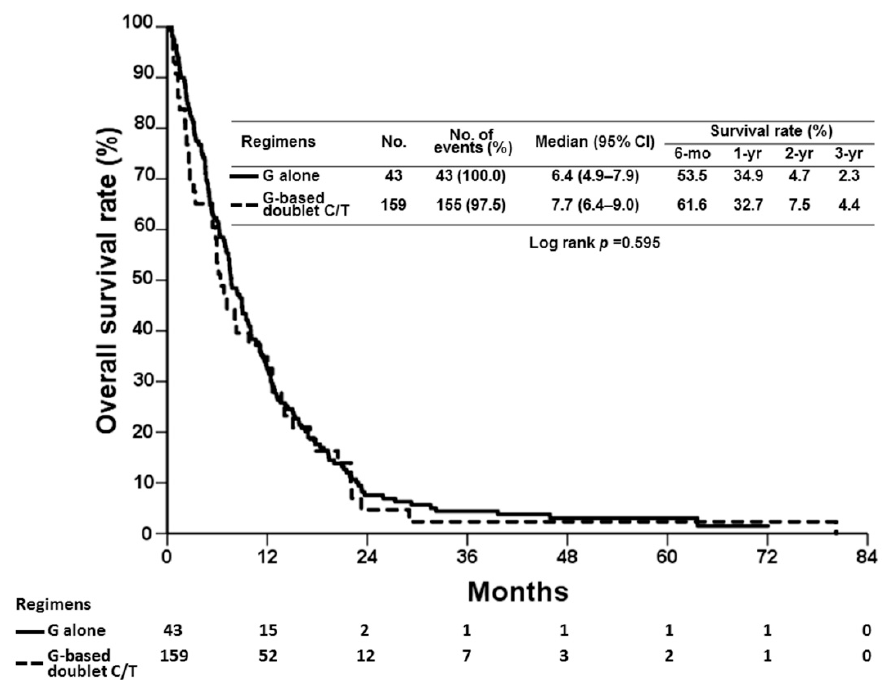
Figure 1. Kaplan–Meier survival curves for overall survival for all patients, stratified according to the chemotherapy (C/T) regimen received: gemcitabine (G) alone or G-based doublet C/T; 95% CI, 95% confidence interval. mo, month; yr, year.